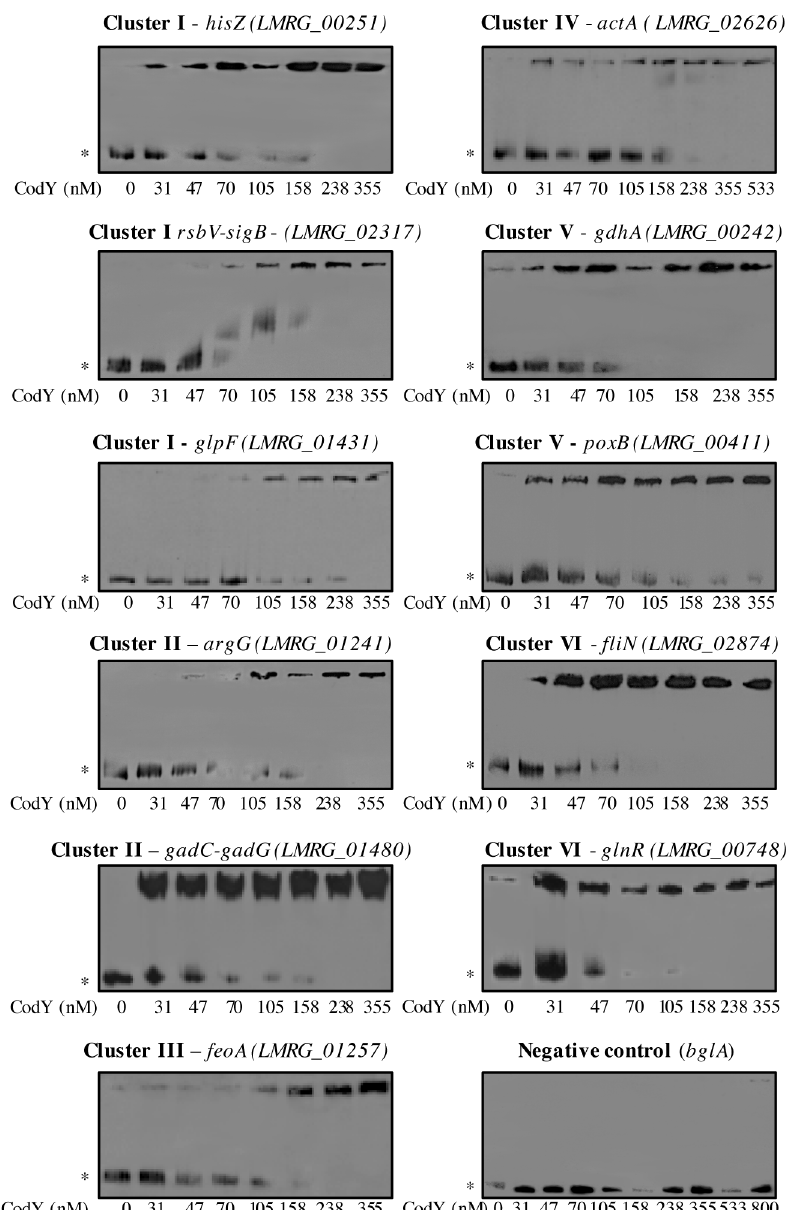
Fig 5. EMSA analysis of CodY binding to select genes from the different clusters. Binding of CodY to 11 regulatory regions of CodY regulated transcriptional units ( hisZ , rsbV , glpF , argG , gadC , feoA , actA , gdhA , poxB , glnR and fliN ) and a control probe ( bglA ). Primers used for amplification of DNA probes are described in S5 Table. Results are representative of at least 2 independent biological repeats. EMSA was performed with 10 mM BCAA for hisZ , rsbV , glpF , argG , gadC gdhA , poxB , glnR and fliN . For feoA and actA BCAAs were not added. Asterisks ( * ) point to unbound DNA